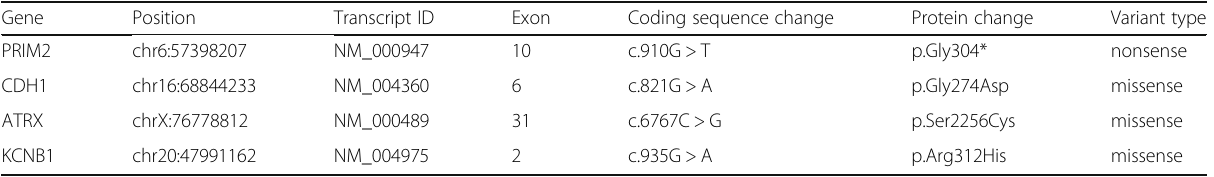
Table 1 Mutations list likely related to LELC pathogenesis